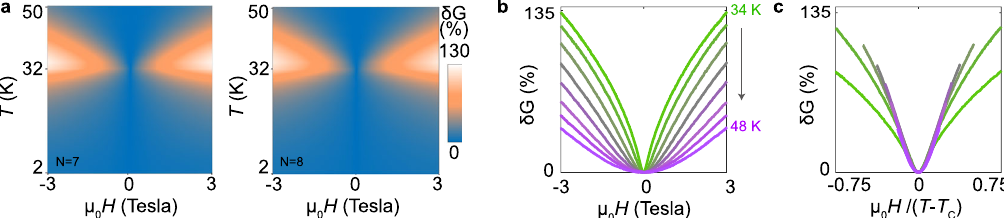
Fig. 2 Temperature evolution of the tunneling magnetoconductance. a Color plot of tunneling magnetoconductance for the 7 (left) and 8 layer (right) device as a function of applied magnetic fi eld μ 0 H (with interval of 0.005 T) and temperature T (with interval of 2 K). The bias voltage is 1 V and 1.4 V for 7 and 8 layer device, respectively. At fi xed applied fi eld, the magnetoconductance is maximum close to T c = 32 K. b Magnetoconductance of seven layer device for T > T c , as T is varied from 34 to 48 K, in 2 K steps. c : when plotted as a function of μ 0 H /( T − T C ), the magnetoconductance curves shown in panel b collapse on top of each other at small fi eld, indicating that in the linear regime the magnetocoductance δ G ( H , T ) depends on H and T only through the magnetization M ( H , T ). In panels b and c , curves of the same color correspond to measurements done at the same